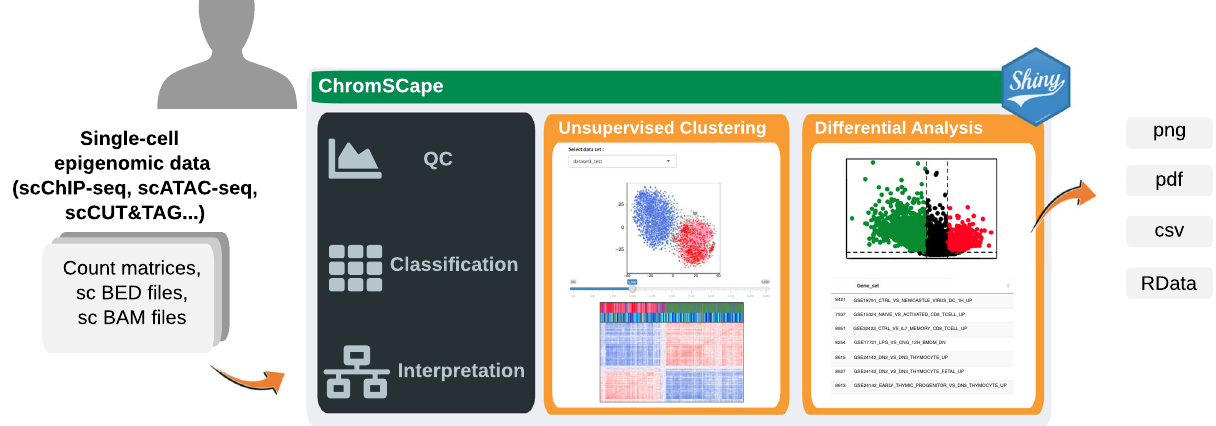
Fig. 1 Representation of ChromSCape work fl ow. Users upload single-cell epigenomic data formatted as count matrices, single-cell BAM or single-cell BED fi les to start the analysis. The application includes Quality Control (QC), Classi fi cation and Interpretation tools. The user can save plots and tables in png, pdf, or csv formats, and R analysis objects in RData